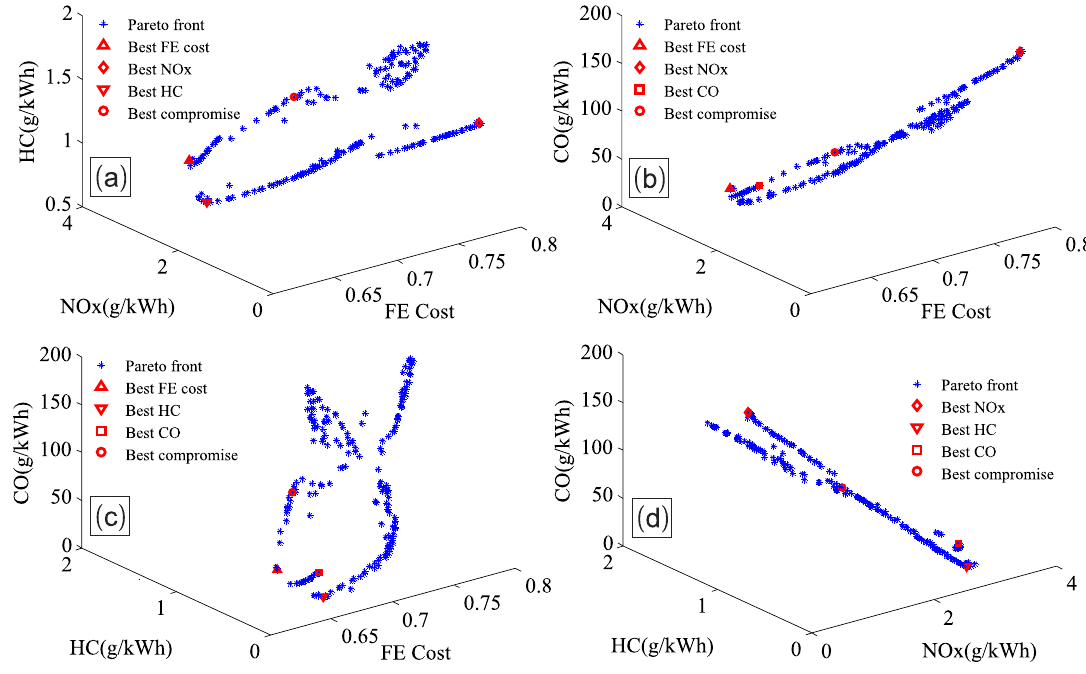
Figure 6. Distribution of the Pareto front. ( a ) Pareto front in FE cost-NO x -HC space; ( b ) Pareto front in FE cost-NO x -CO space; ( c ) Pareto front in FE cost-HC-CO space; and ( d ) Pareto front in NO x -HC-CO